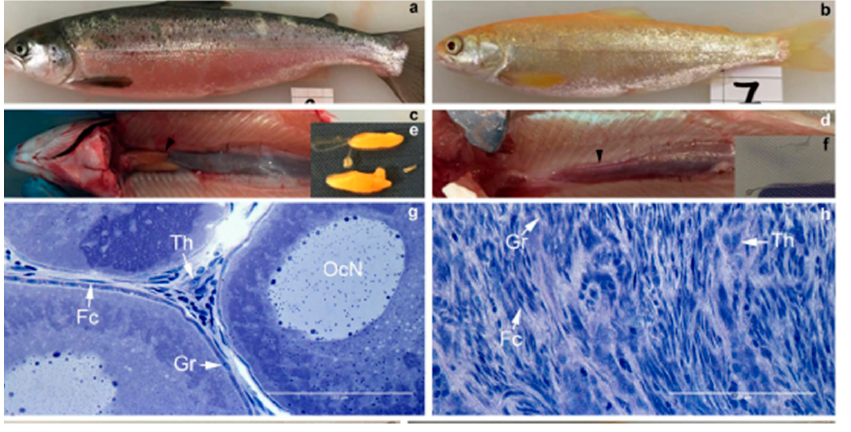
Figure 7. Morphology and histology of one-year-old dnd/alb KO and a control Atlantic salmon. Figure 7 presents the control fish on the left side ( a , c , e , g ). The dnd / alb KO fish is presented on the right side ( b , d , f , h ). Fish b is a female dnd / alb KO fish. D and f show the gross morphology of the female dnd / alb KO in comparison to the gross morphology of the control female ( a , c , e ): the lack of the ovarian bulb in comparison to the control ( e ); g and h show the histology of the female gonad in dnd / alb KO fish ( h ) in comparison to the control ovary ( g ). Abbreviations: Th—theca cell; OcN—oocyte nucleus; Gr—granulosa cell; Fc—fibrocyte [89]. The dnd/alb KO mutant Atlantic salmon were produced through double allelic muta- tions using CRISPR/Cas9. As a result, the fish were completely lacking pigmentation and were devoid of germ cells in F0. The study showed that the biallelic KO sustains with high the germ cells are not required for female sex differentiation, but may be required for establishing a normal structure in the ovaries in Atlantic salmon. This study demonstrated for the first time that CRISPR/Cas9-mediated KO of dnd leads to a complete loss of germ cells in F0 generation in fish species